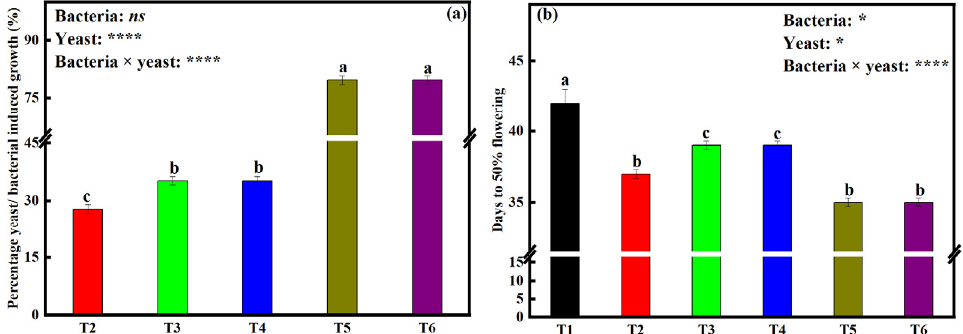
Figure 3. Measurements of ( a ) percentage yeast/bacterial-induced growth and ( b ) days taken to reach 50% flowering of soybean seedlings under different microbial treatments. Data (means ± SE, n = 5) followed by different letters denote significant differences between treatments at p < 0.05 according to Tukey’s HSD. p -values of two-way ANOVAs of bacteria, yeast, and their interaction (bacteria × yeast) are indicated: p < 0.05, *; p < 0.01, **; p < 0.001, ***; p < 0.0001, ****; ns, not significant. Treatments: non-inoculated soybeans (T1), soybean inoculated with B. japonicum (T2), S. cerevisiae (T3), S. exiguus (T4), B. japonicum × S. cerevisiae (T5), or B. japonicum × S. exiguus